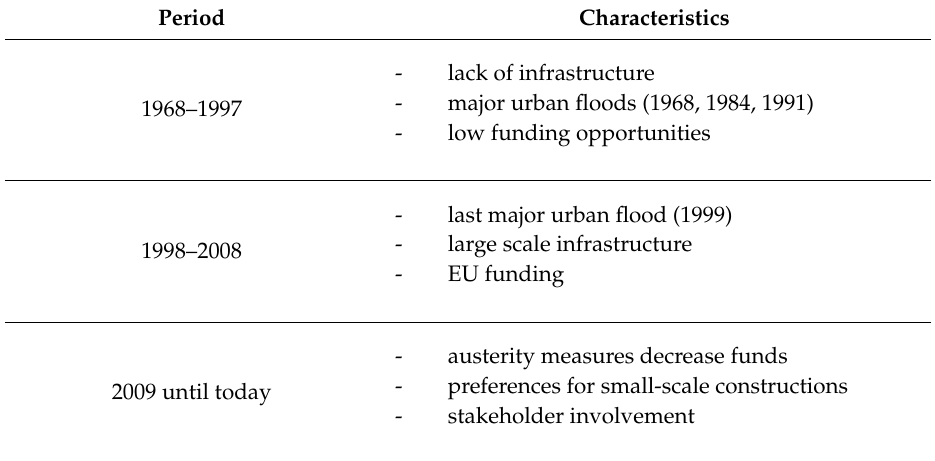
Table 1. Evolution of flood risk management in Rethymno (adapted from